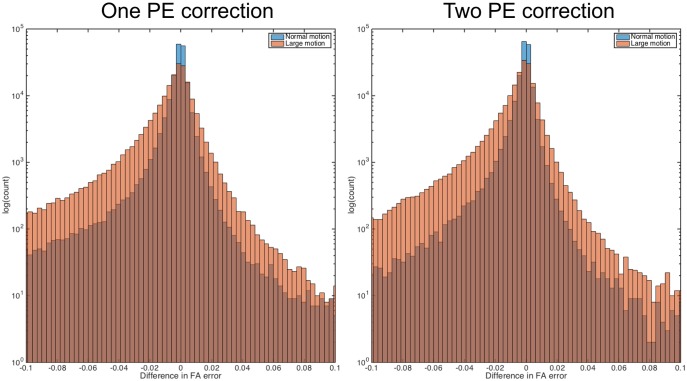
Error distribution.Histogram of the difference in absolute FA errors over the full brain, for datasets corrected for motion and static susceptibility: |ΔFAstatic| − |ΔFAdynamic|, so the heavy tail for negative values indicate higher errors for the dynamic case.